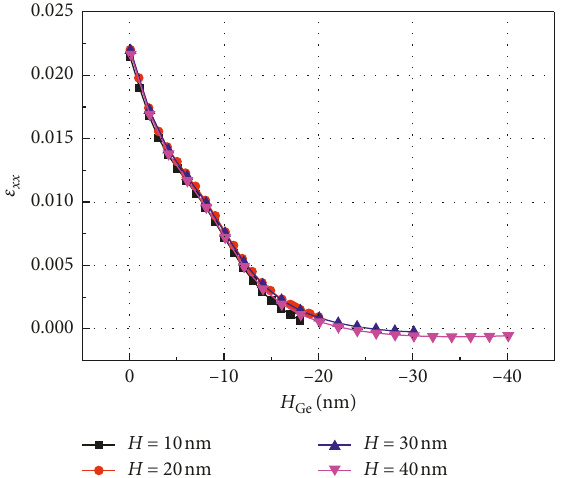
Figure 14: Vertical strain distribution at different step